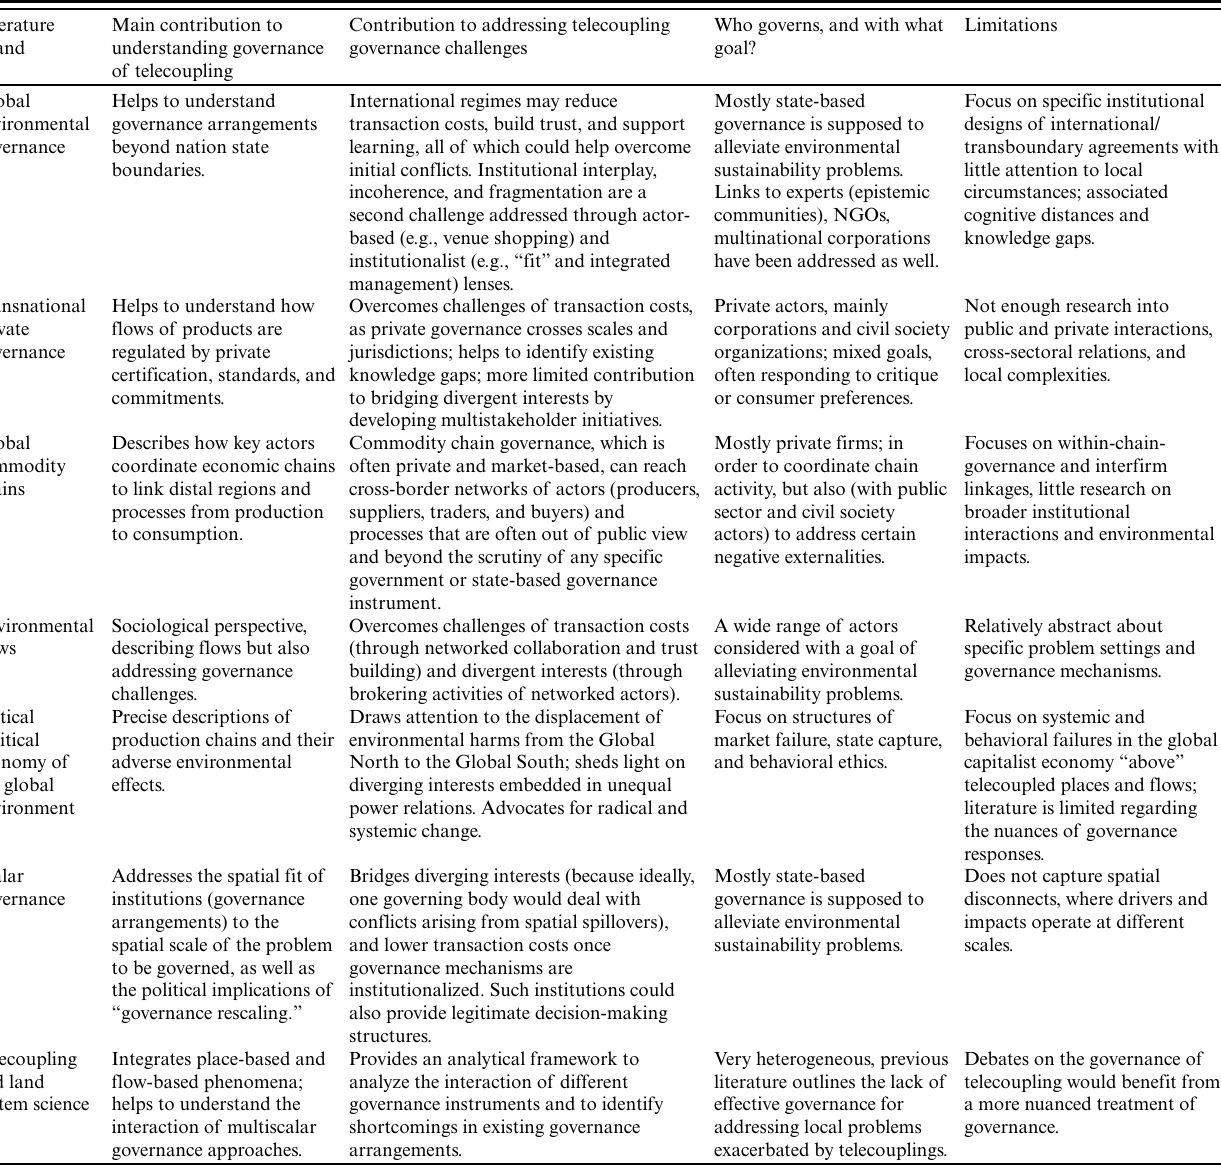
Table 1 . Overview of literature strands important to the governance of telecoupling Literature